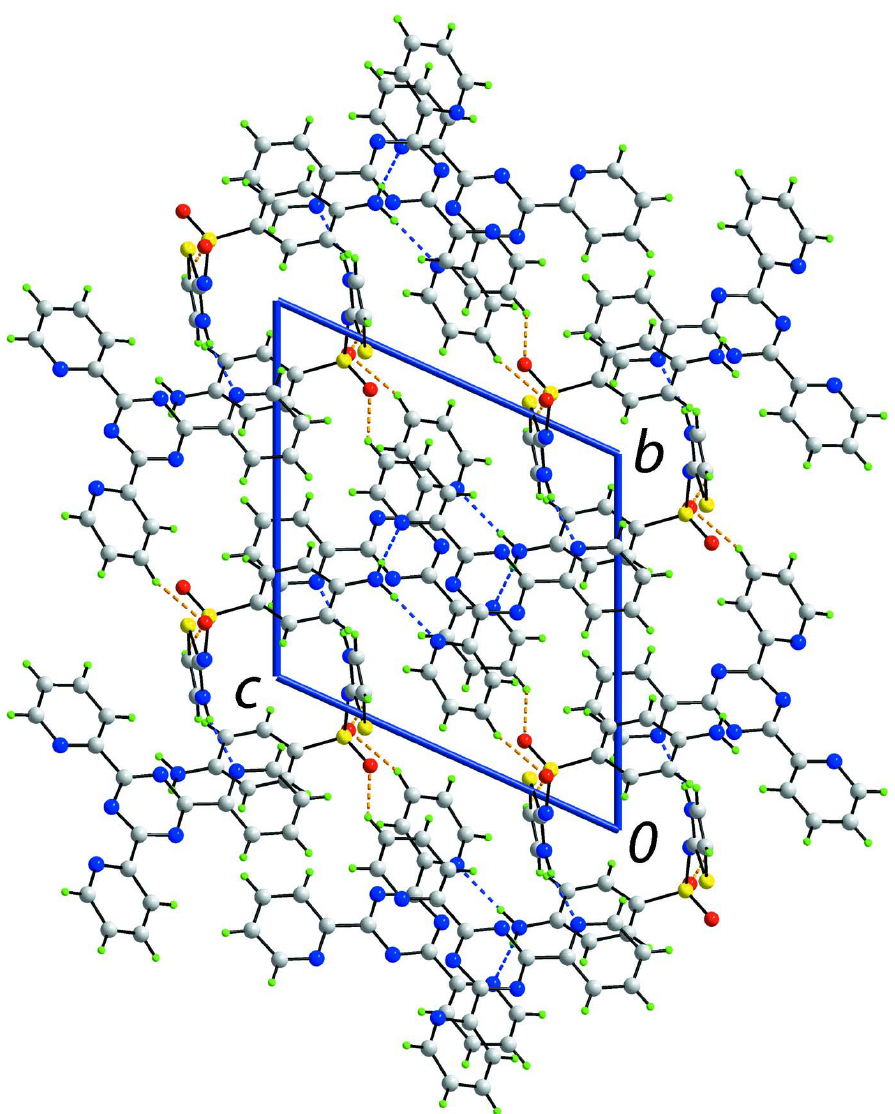
Figure 3 Unit-cell contents in (I) viewed in projection down the a axis. The N—H···N hydrogen bonds and C—H···O interactions are shown as blue and orange dashed lines,